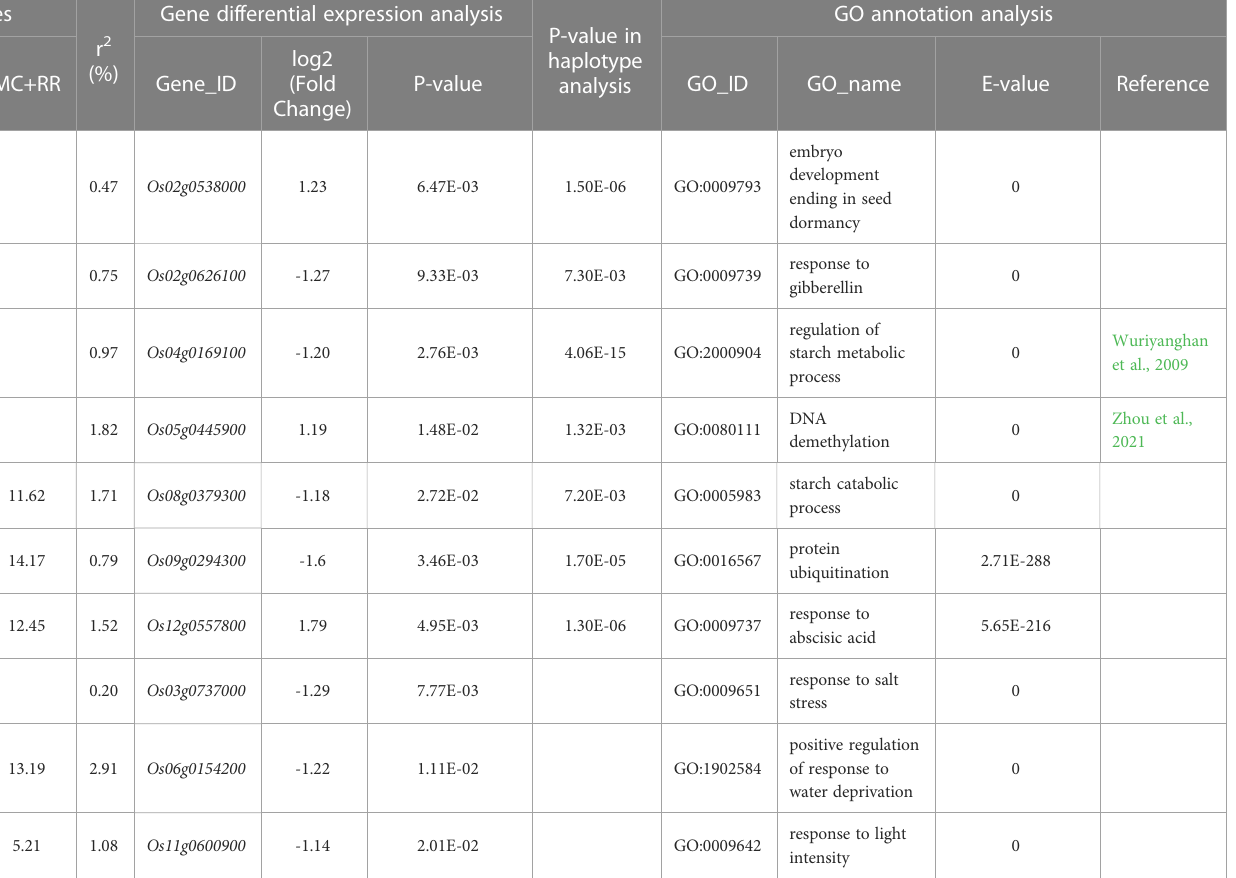
TABLE 3 Key candidate genes and gene-by-environment interactions for grain size related traits in rice. QTN/ No. Trait GEI